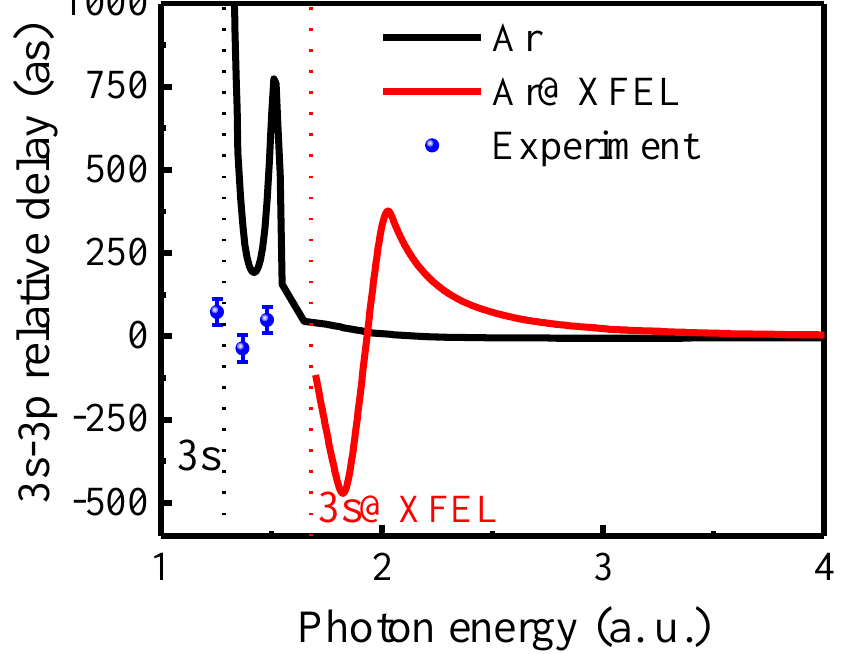
Figure 10. The time delay difference of 3s and 3p subshell ( τ (3s)- τ (3p)) of Ar (black) and Ar@XFEL (red) in the RRPA calculation is compared with that from the experiment (blue) [53]. Vertical lines show the 3s subshell threshold for Ar (black) and Ar@XFEl (red).